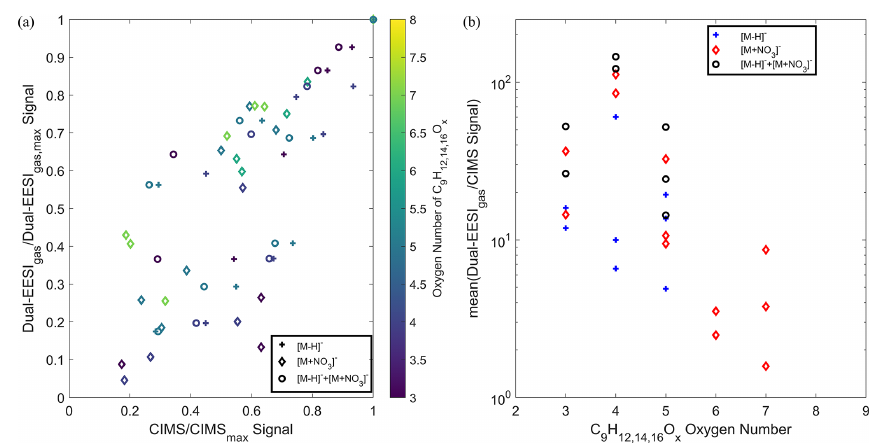
Figure 6. Comparison between the Dual-EESI and nitrate CIMS for a series of TMB oxidation products in the gas phase. Since some analytes detected in the nitrate CIMS might have two ionization pathways via deprotonation or nitration, for each analyte M, we compared [ M − H ] − , [ M + NO ] − and [ M − H ] − +[ M + NO ] − from the nitrate CIMS to the [ M + Na ] + of the Dual-EESI. Please note that summation of detected 3 3 ions in the CIMS was only implemented for ions that can be detected in both [ M − H ] − and [ M + NO 3 ] − of the same compound, where their respective sensitivities in the nitrate CIMS may differ. (a) The normalized signal of the Dual-EESI and the nitrate CIMS to their respective maxima where the color scale indicates the oxygen number. (b) Averaged intensity ratio between the Dual-EESI in the gas phase and the nitrate CIMS for TMB products with different oxygen numbers (C 9 H 12 , 14 , 16 O 3 − 8